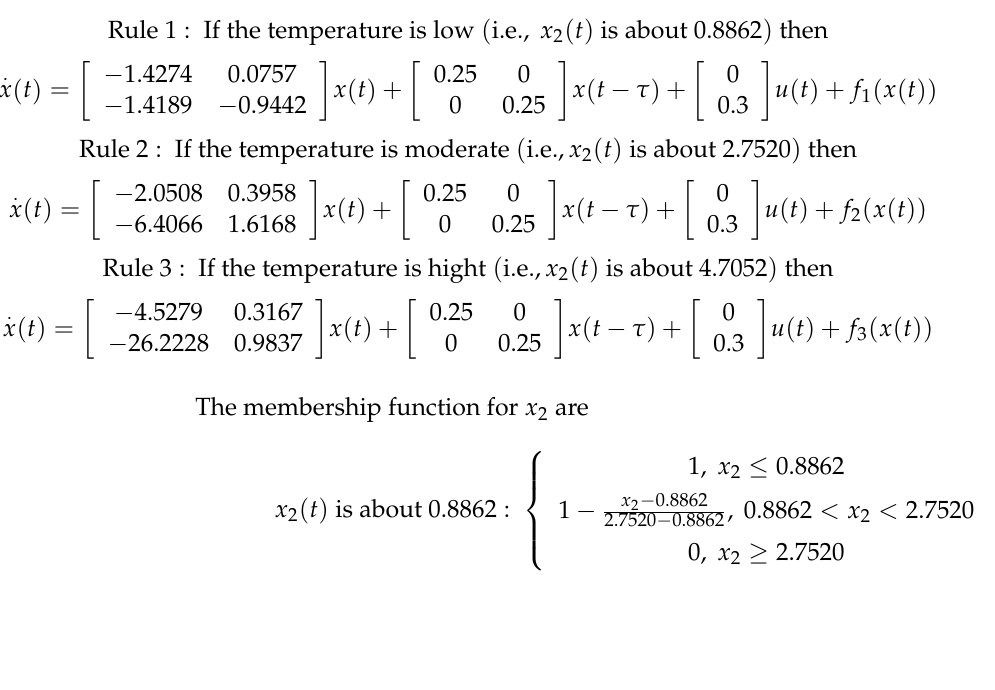
Figure 4. Trajectories for 𝑥 1 and 𝑥 2 .